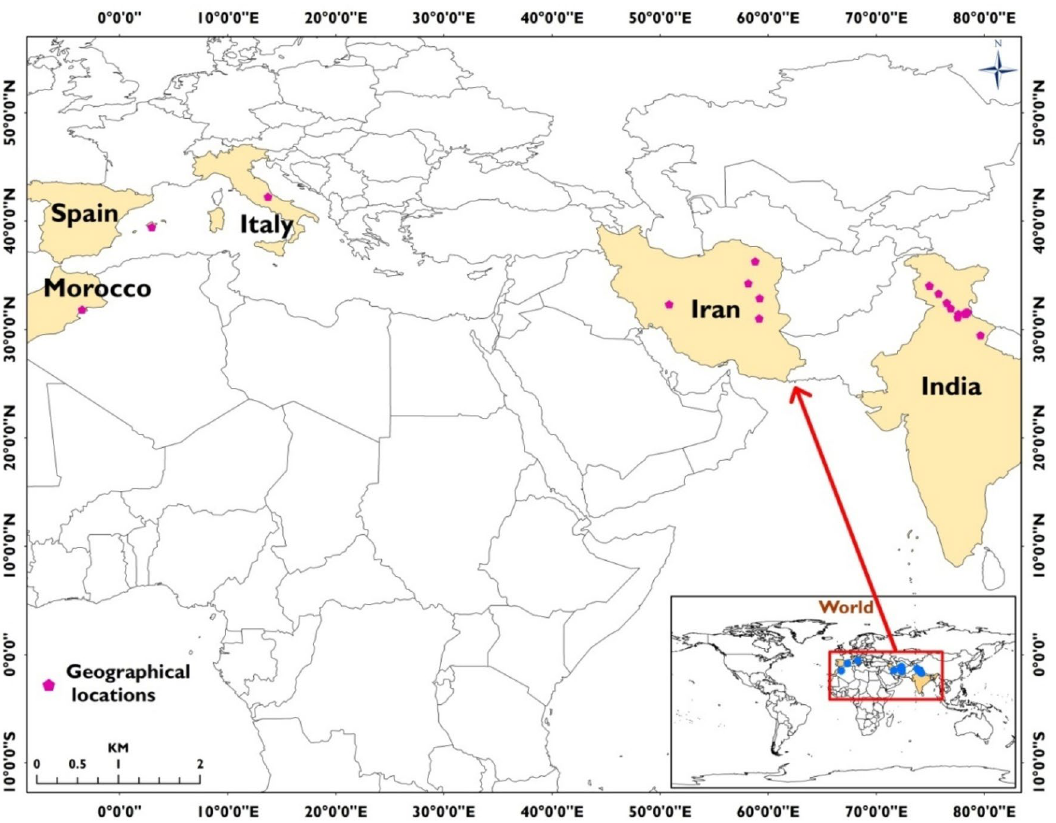
Figure 3. Geographical locations of Crocus sativus L. (saffron) used for ENM (prepared using ArcGIS 10.4.1; https:// www. esri.